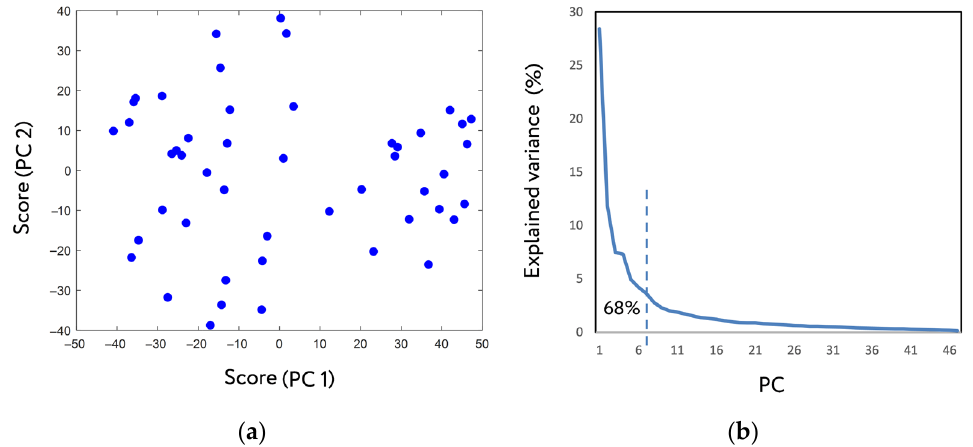
Figure 2. Principal component analysis (PCA) of the mass spectrometry data of the blood plasma samples of healthy male volunteers. ( a ) PCA score plot of the first two principal components of the data. ( b ) The plot of variance explained by each principal component (PC). The first seven PCs explain 68% of blood metabolome variance.